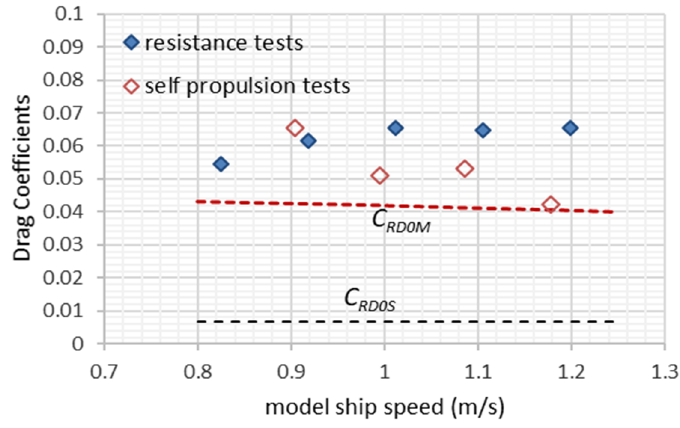
Figure 7. Obtained rudder drag coefficients.